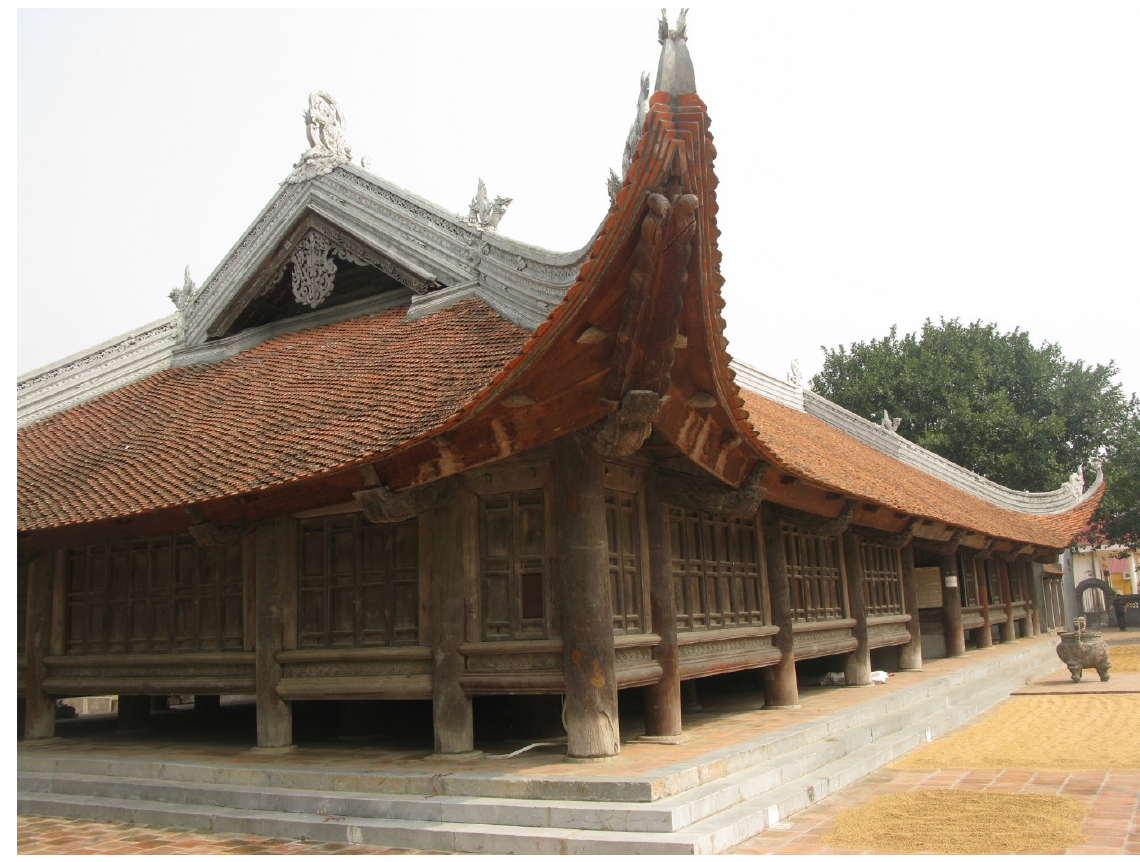
Figure 2. Ancient architecture of Vietnam. Source: https://www.bestpricetravel.com/travel-guide/vietnamese-architec- ture-reflecting-one-part-of-vietnamese-culture-157.html. Accessed 14 April 2021